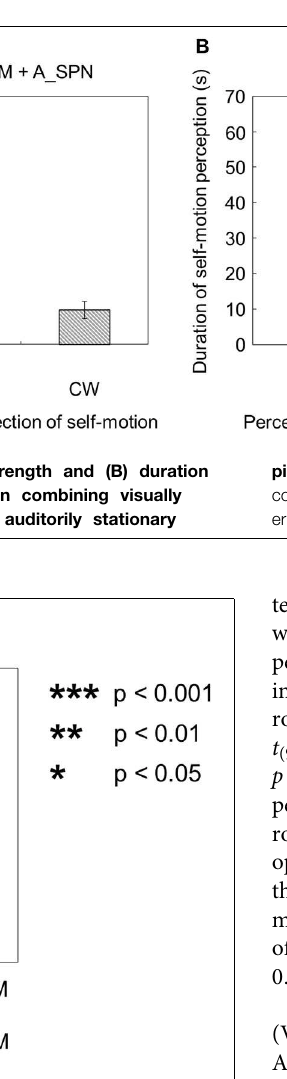
FIGURE 6 | Averaged values of the onset latency of self-motion perception in the three experimental conditions including visual shearing motion. In each graph, the left bar shows the condition combining visually horizontal shearing motion (V_HSM) and no auditory stimulus (A_NPN). The middle bar is the combination of visual horizontal shearing motion between the vertically adjacent stripe-shaped area (V_HSM) and stationary pink noise (A_SPN). The right bar is the combination of the vertically adjacent stripe-shaped area (V_HSM) and horizontal one-directional motion simulating rotation of pink noise around the yaw axis (A_HOM). The error bars represent standard error (SE).